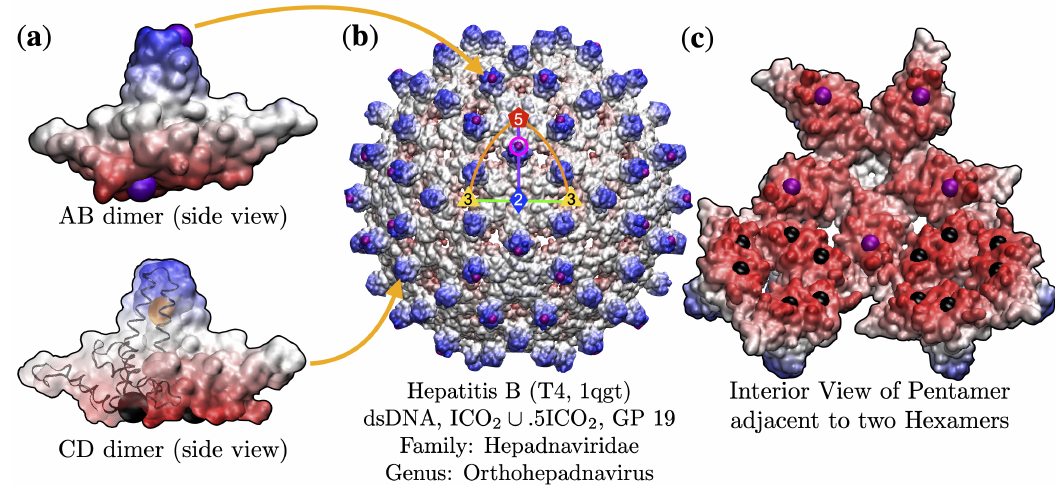
Figure 2. ( a ) The Hepatitis B capsid (HBV, T4, 1qgt [26]) is composed of 240 chemically-identical proteins, denoted chains A, B, C and D. These protein chains are arranged in two distinct dimers (AB and CD). According to point arrays, the AB dimer is constrained at the top (chain A and B, purple) and at the bottom (chain B only, purple). The CD dimer is constrained midway up the alpha helices (Both C D, orange) and then individually at the bottom of the C and D proteins (black). ( b ) These 120 dimers are arranged with icosahedral symmetry, leading to 12 pentamer and 30 hexamer subunits. In general, there are no covalent bonds between viral capsid proteins, including these dimers. Therefore other effects, such as hydrophobic and electrostatic interactions are required for stabilization [27–29]. Quasi-equivalence through icosahedral symmetry is the mechanism that ensures these interactions are plentiful and dispersed enough for capsid stability [15]. In the case HBV, extensive molecular dynamics simulations have shown these dimers to have different vibrational frequencies [24]. This difference is consistent with point arrays, as the AB dimer is constrained at the top and bottom, and the CD dimer is constrained at the middle and bottom. We have highlighted the C-chain protein backbone, which is constrained at two points to each side of the point array element (orange). The full HBV capsid, with the asymmetric unit (AU) highlighted between the 5-,2- and 3-fold axes. The AB dimers protrude between the 5- and 2-fold axes at gauge point 19 (pink circle). This gauge point determines nearly all of the other interior points, indicating that having protruding features at these locations puts constraints on the entire interior structure. None of these constraints are required by icosahedral symmetry. Gauge point 19 imposes inflexible restrictions on the choice of point arrays, either ICO 2 or IDD 5 , are the only two point arrays available to this gauge point [2,3]. These are known as sister arrays, and are identical except for a single radial level and without more coordinate information on the genome, are indistinguishable at this level [3]. Each of these point arrays specify restrictions on three of the four protein chains A, C and D. ( c ) The interior view of a pentamer and two hexamer subunits. We see that the point arrays put constraints on the interior of the hexamer (black) and pentamer (purple). The two point arrays available to GP 19, ICO 2 and IDD 5 specify all the points shown in ( a – c ), except the purple points seen the interior pentamer in ( c ). These purple points comes from the union of ICO 2 ∪ 5ICO 2 . This array imposes a restriction on chain B and is therefore the best-fitting point array. There is not a similar union available for IDD 5 . It is important to note that none of the points of point array ICO 2 ∪ 5ICO 2 can be removed or moved, there is only 1 degree of freedom, the overall radial scaling